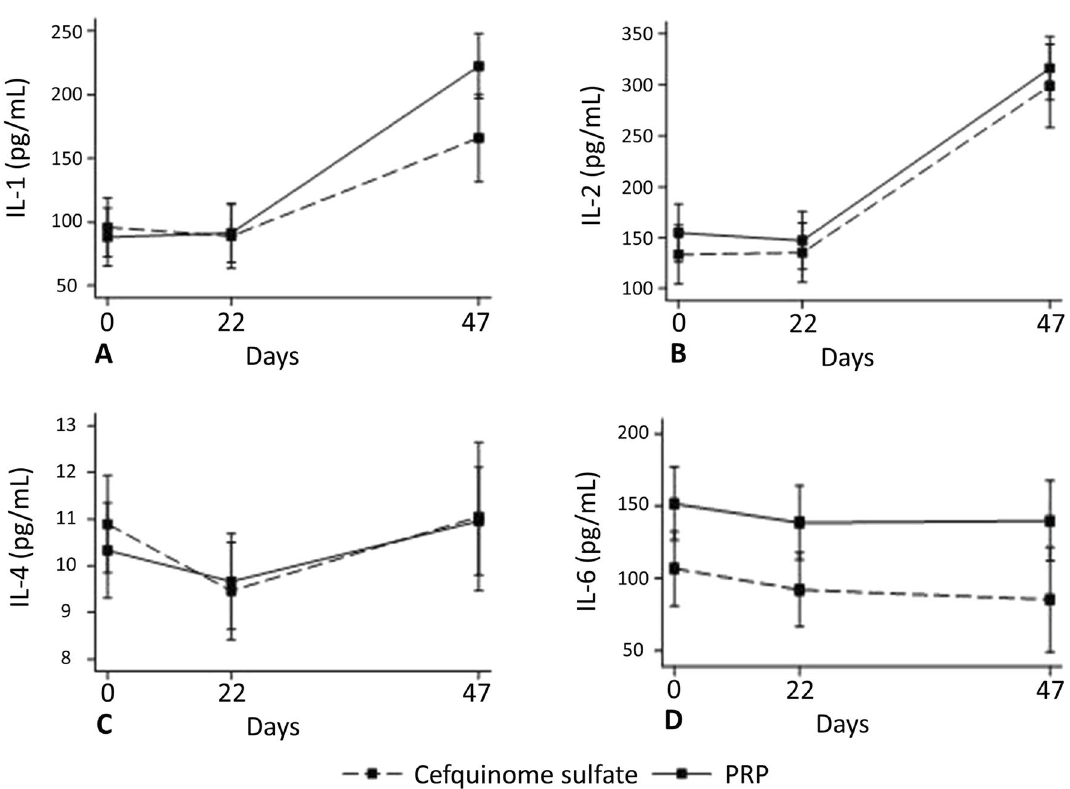
Figure 7. Mean concentration (95% CI) of milk interleukin 1 (IL-1) ( A ), IL-2 ( B ), IL-4 ( C ), and IL-6 ( D ) of cows with subclinical mastitis intramammary treated with 10 mL of P-PRP (pure platelet rich plasma) or 75 mg of CS (cefquinome sulfate) over three consecutive milkings. Zero represents the day of the treatment. Day 47 corresponds to cows that were treated twice, as they were refractory to the first